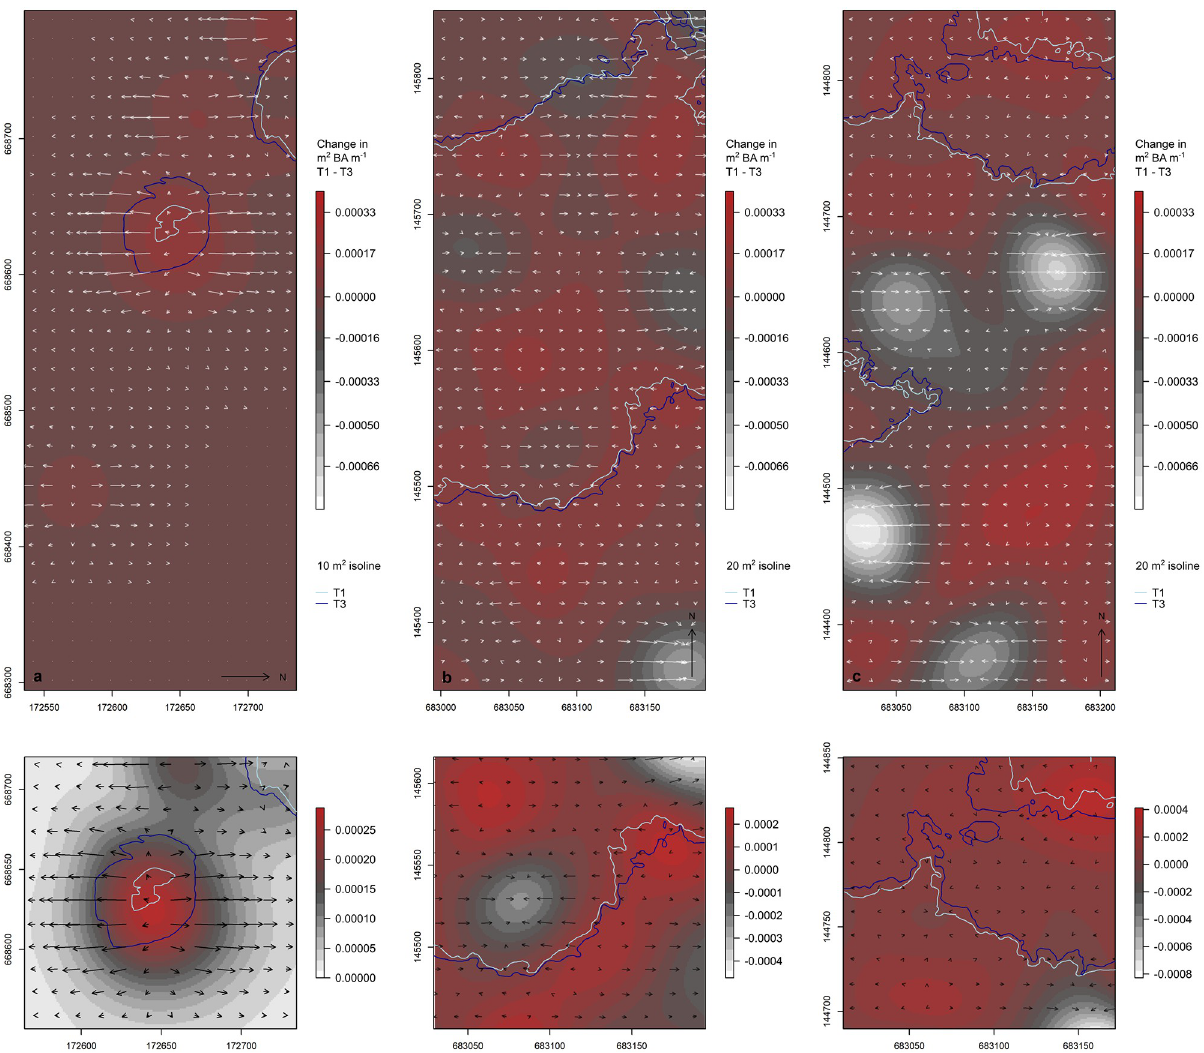
Fig 4. Net change in m 2 of BA m − 1 between 1994/1995 and 2007. Overview (upper) and details (lower; select examples) of vector fields illustrating change in m 2 of BA m − 1 between the first (1994/1995; T1) and third (2007; T3) censuses, for edoro1 (a), lenda1 (b), and lenda2 (c). Arrow orientation conveys the direction of change (aspect of the surface), while the length of each arrow conveys the magnitude of change (slope of the surface). A systematic sample of vectors is shown for graphical clarity, and vector magnitudes have been uniformily scaled to improve visual clarity. Note the different color ramp value ranges in the lower panels. All coordinates are in UTM 35N